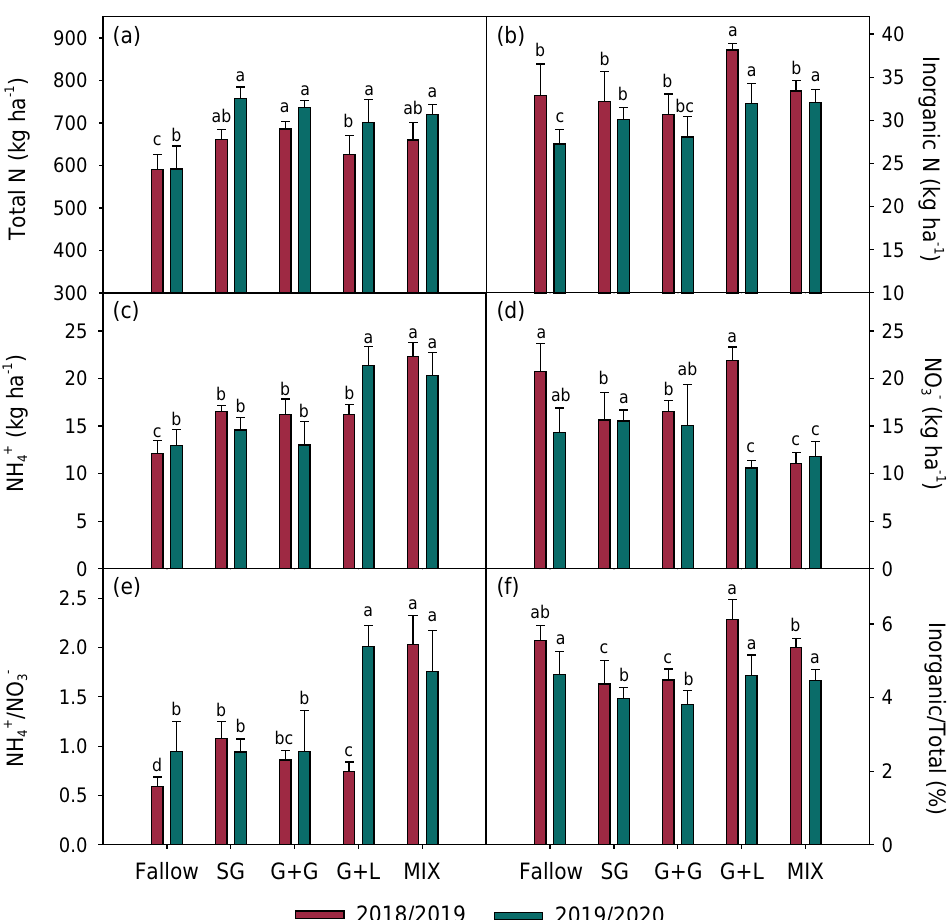
Figure 1. Stock of total nitrogen, inorganic nitrogen, ammonium and nitrate in the soil (0.00-0.20 m); the relationship between ammonium/nitrate; and the relation between the percentage of inorganic nitrogen to total nitrogen in the soil, in cotton pre-sowing. SG: single grass; G+G: grass + grass; G+L: grass + legume; MIX: three species